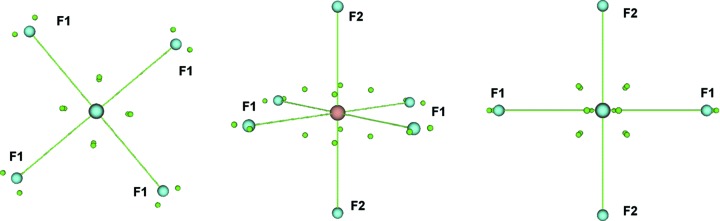
Graph depicting the (3, +3) critical points (green spheres) in the Laplacian as determined from the theoretical model of the UF6
− ion, shown in three orientations.